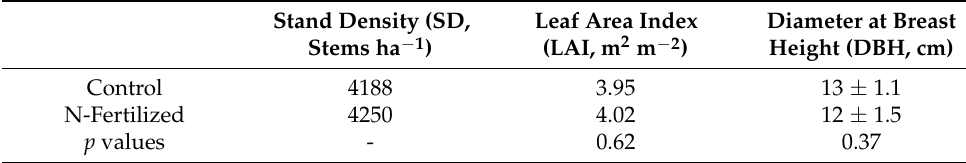
Table 1. Stand density (SD) and the average of leaf area index (LAI; n = 8), and diameter at breast height (DBH; n = 16) of sap flow measurement